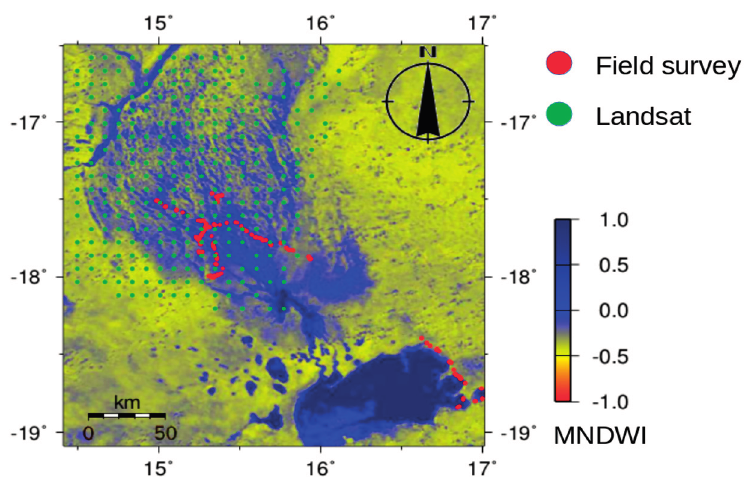
Figure 7. The locations where ground-truthing data were obtained. The ground-truthing data from the field survey were obtained mainly during the dry season, whereas the ground-truthing data from the Landsat data were obtained during a cloud-free day during the rainy season. The background image is the MNDWI distribution derived from the MODIS data (24 March